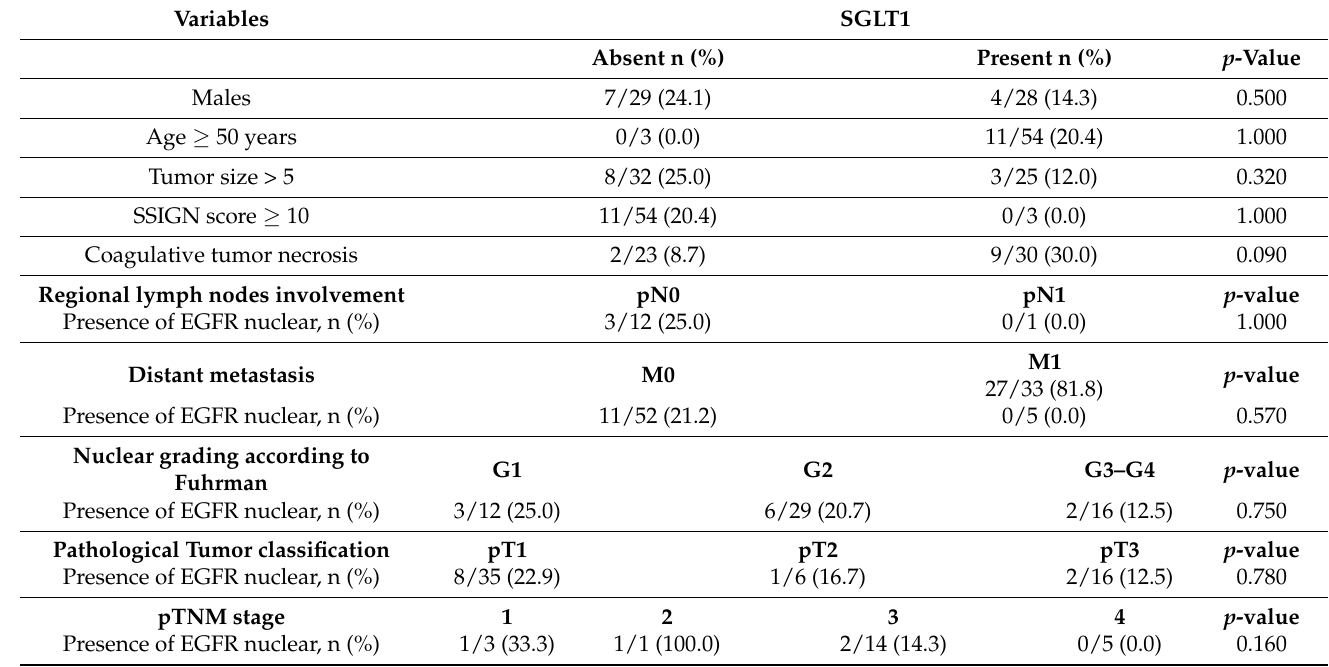
Table 3. Correlation between EGFR nuclear expression and clinico-pathological features of patients with CCRCC.